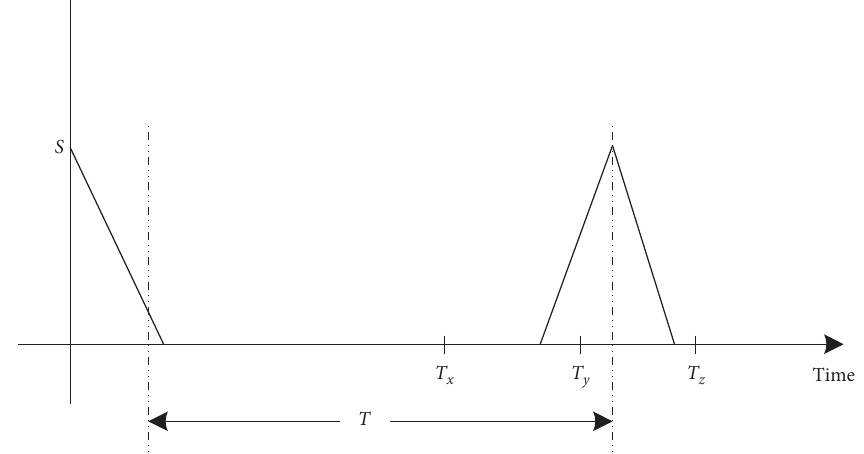
Figure 6: Buffer stock change diagram in a cycle for T